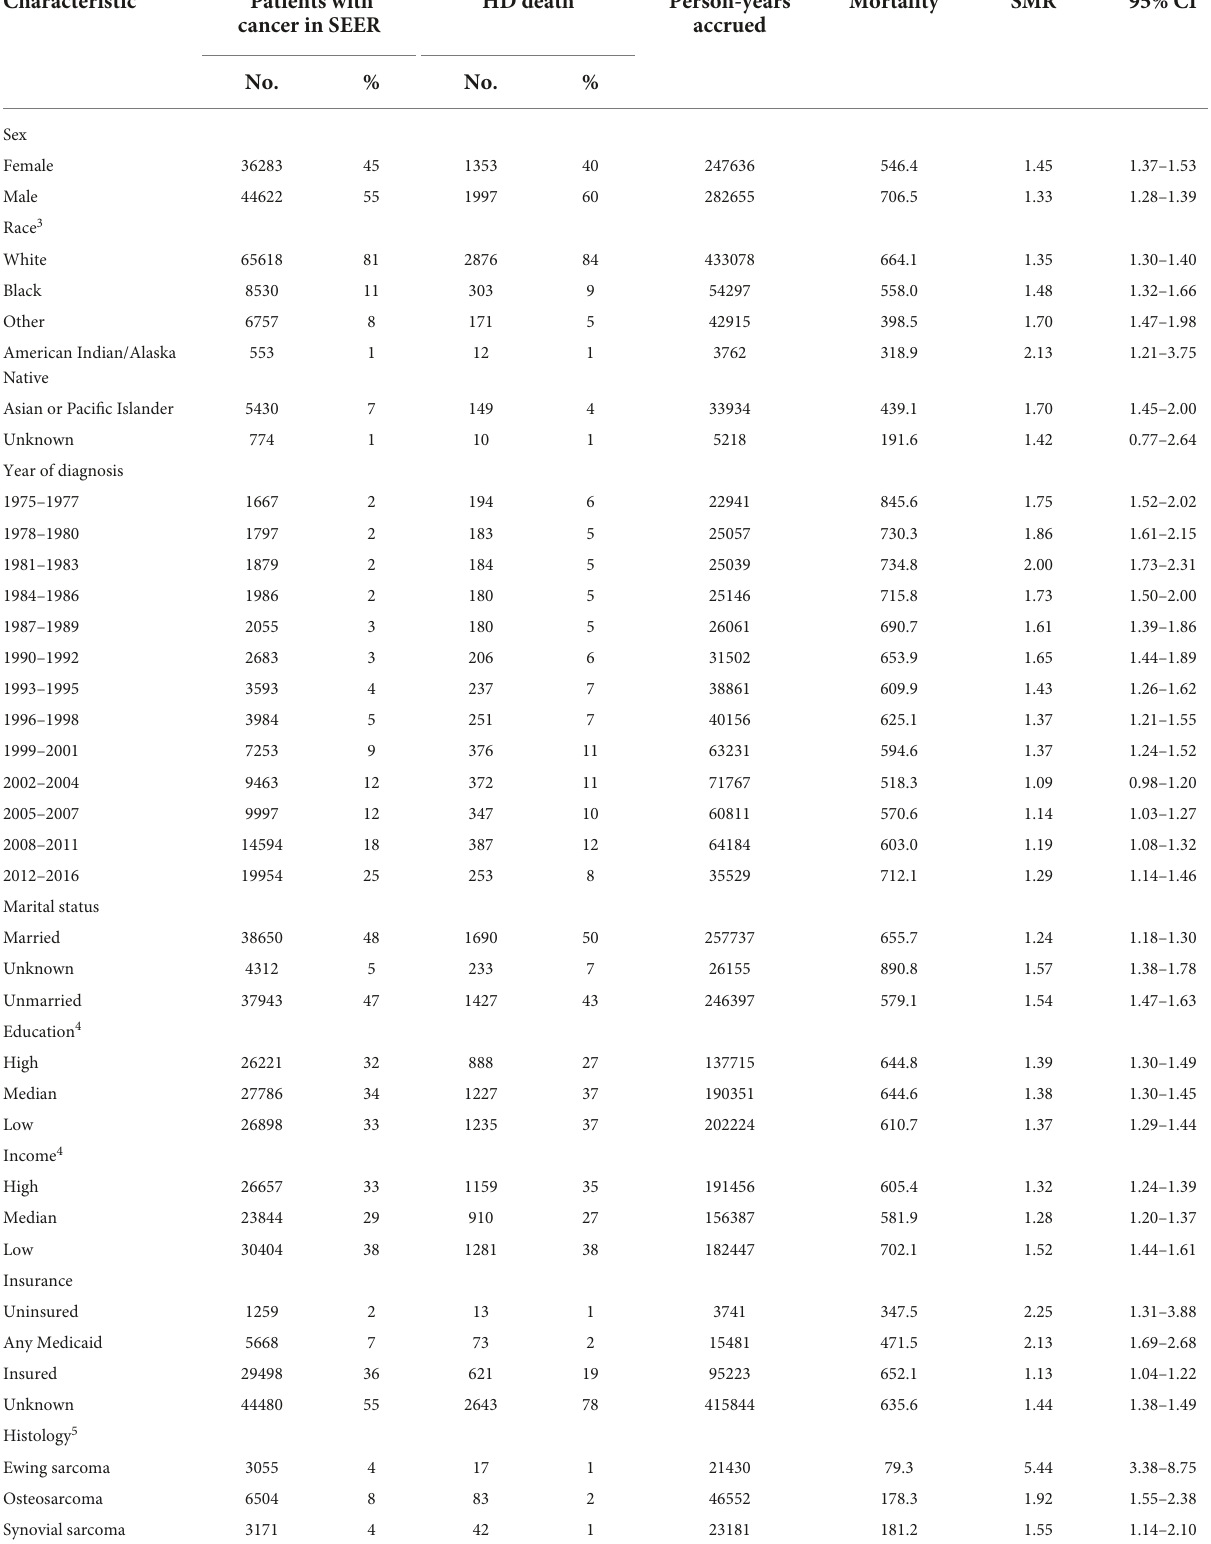
TABLE 1 Death from HD among patients with bone and soft tissue sarcomas by demographic and tumor characteristics. Characteristic Patients with cancer in